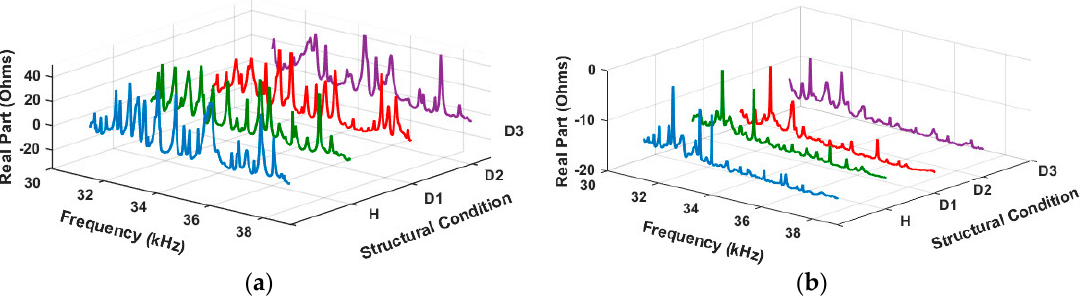
Figure 7. Electromechanical Impedance (EMI) signatures for various structural conditions (H, D1, D2, and D3): ( a ) PZT#1; and ( b ) PZT#2. and D3): ( a ) PZT#1; and ( b ) PZT#2.